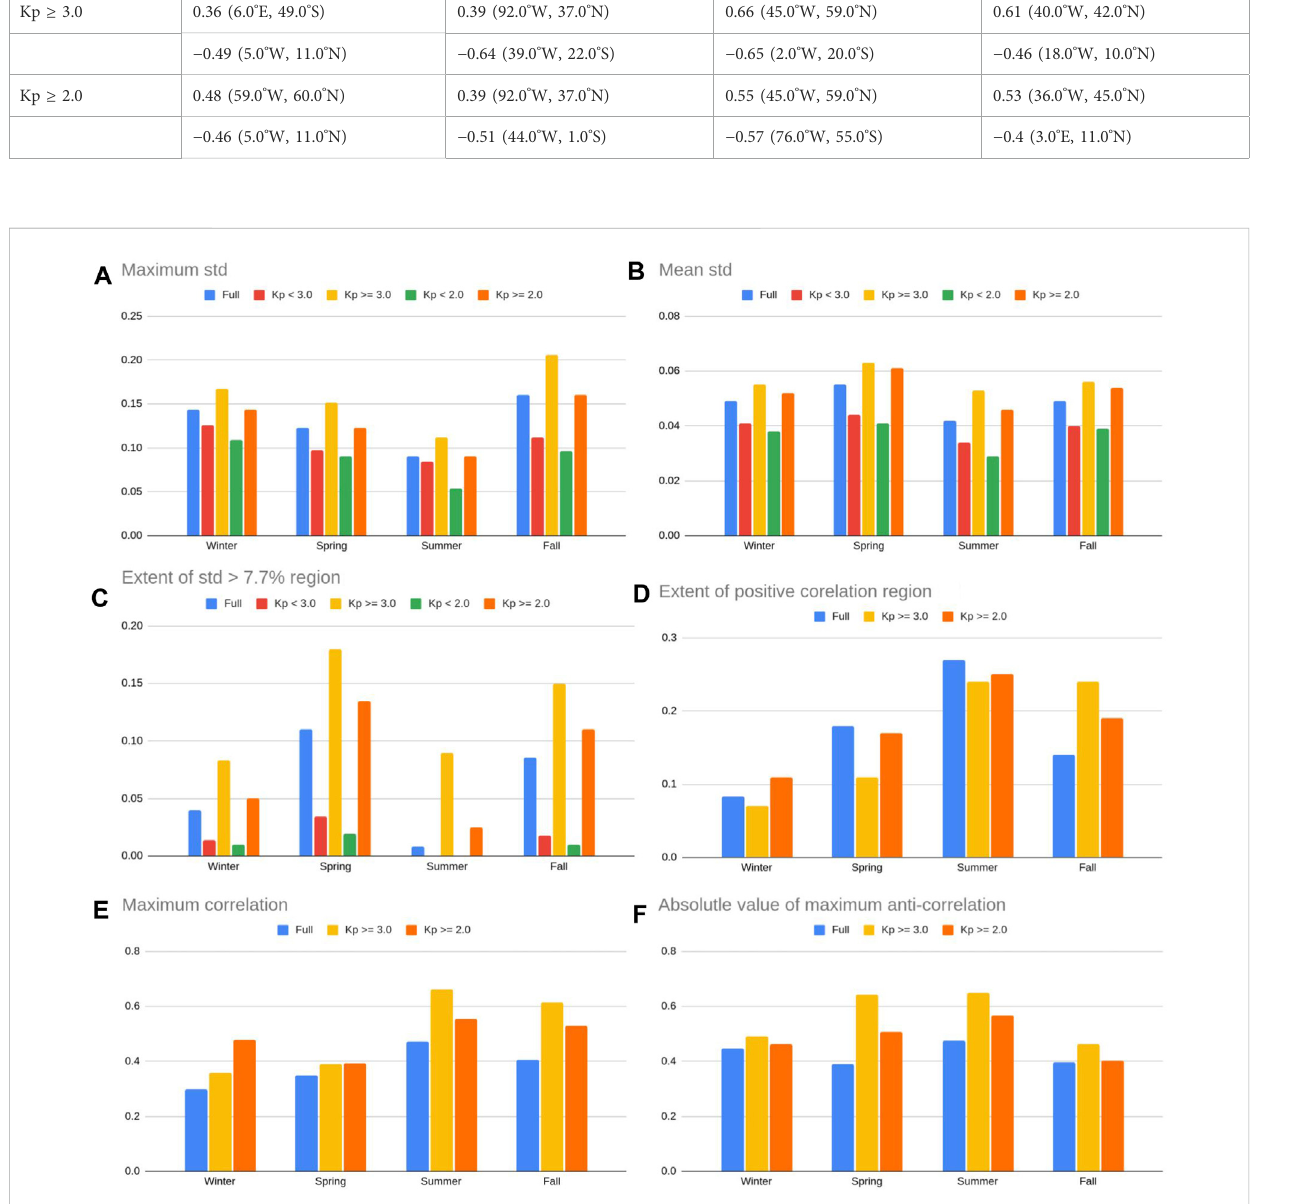
Similar to the variability, the extent of the positive correlation region and the maximum correlation show apparent seasonal dependencies. The extent of the positive correlation region is smallest during Winter (8.3% of the GOLD fov) and largest during Summer (27% of the GOLD fov) for the full dataset